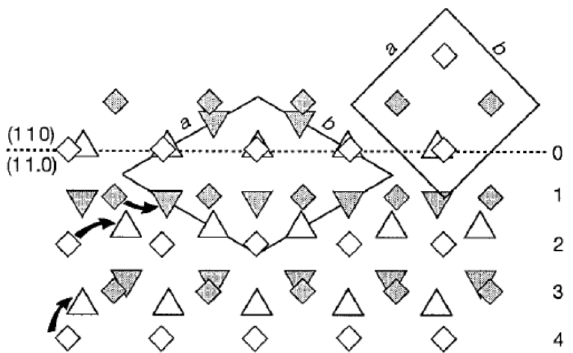
Figure 24. Scheme of the transformation mechanism of iPBu from form II to form I. A tetragonal cell of form II and a trigonal (hexagonal) cell of form I are indicated. The 11/3 and 3/1 helices of forms II and I are represented as squares and triangles, respectively. The different helical hands are shown as light and shaded. The transformation is initiated in layer 0 and propagates both sideways and downwards. The lateral shifts of chains in layers 1 and 2 and significant lattice shrinkage in the vertical direction is manifested by helix movements in layer 4. Reproduced with permission from Ref. [134], copyright 1994 Chapman & Hall.